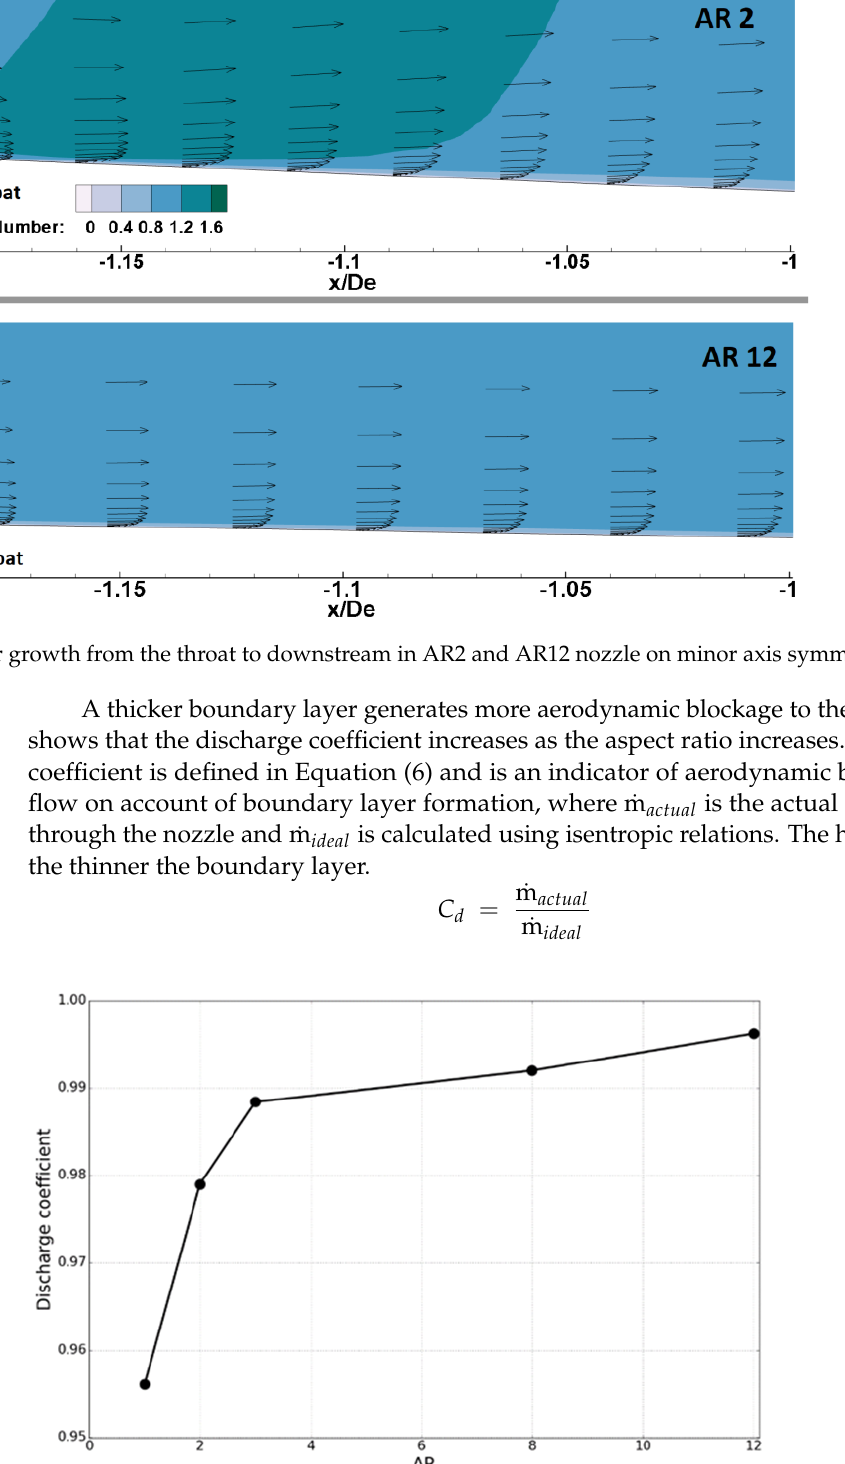
Figure 5 . AR vs. discharge coefficient.